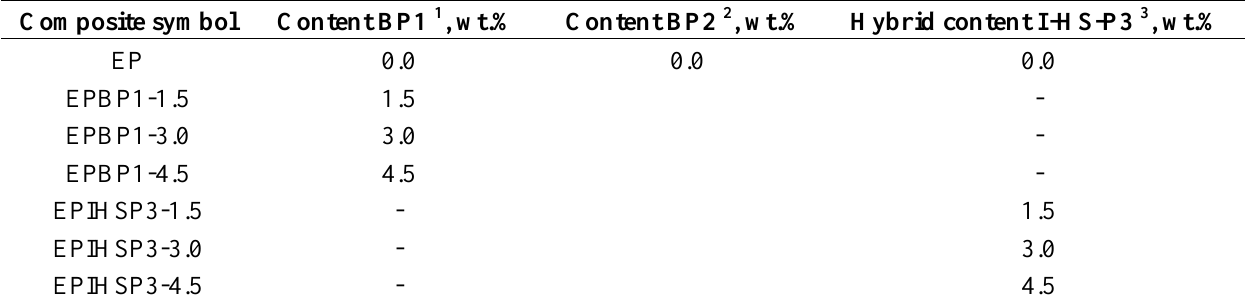
Table 2. Composition of test samples based on epoxy